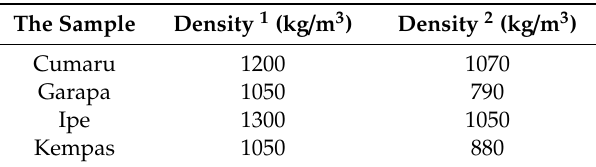
Table 2. The density of samples.